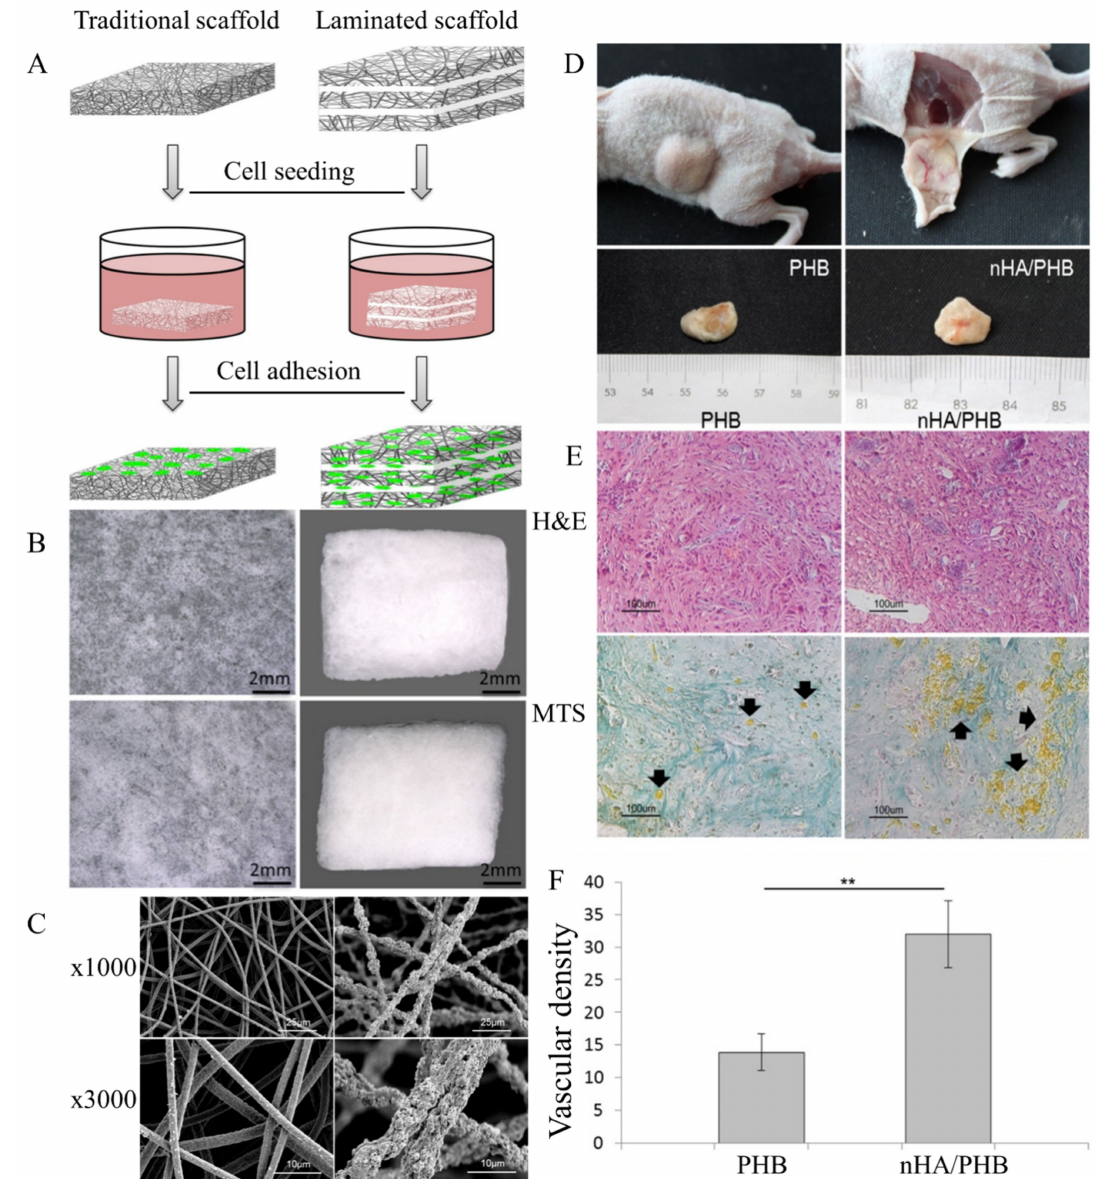
Figure 4. ( A ) Schematic diagram of the traditional electrospun scaffold and laminated electrospun scaffold. ( B ) Surface features of a traditional electrospun scaffold, a thin-layer fiber membrane and a laminated scaffold. ( C ) SEM micrographs of the structure of the laminated electrospun PHB scaffold and the nHA/PHB scaffold. ( D ) Representative macroscopic images of PHB-hMSCs and nHA/PHB-hMSCs composites removed from nude mice after 2 months. ( E ) Appearance of